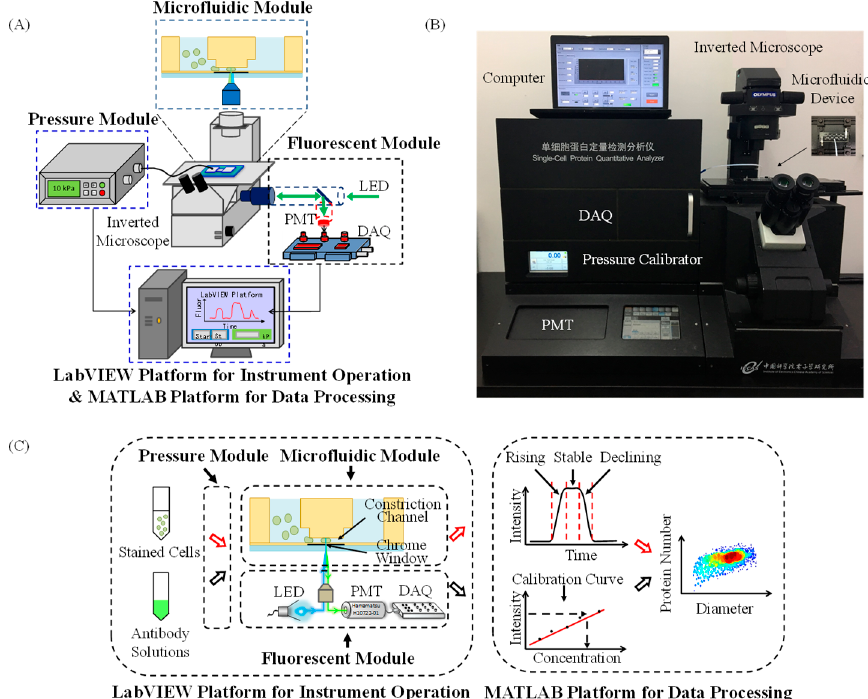
Figure 1. ( A ) Schematics and ( B ) a prototype of the fluorescent microfluidic flow cytometry enabling the measurement of copy numbers of specific intracellular proteins at the single-cell level. The developed instrument had five key components: A microfluidic module, a fluorescent module, a pressure module, a LabVIEW platform for instrument operation, and a MATLAB platform for data processing. ( C ) Working flow chart of the developed microfluidic instrument. Under the control of the LabVIEW platform for instrument operation, the pressure module flushed cells stained with fluorescence-labelled antibodies through the constriction channel of the microfluidic module while fluorescent intensities were quantified by the fluorescent module and then were further translated to the copy number of specific intracellular proteins at the single-cell level, leveraging the MATLAB platform for data processing.